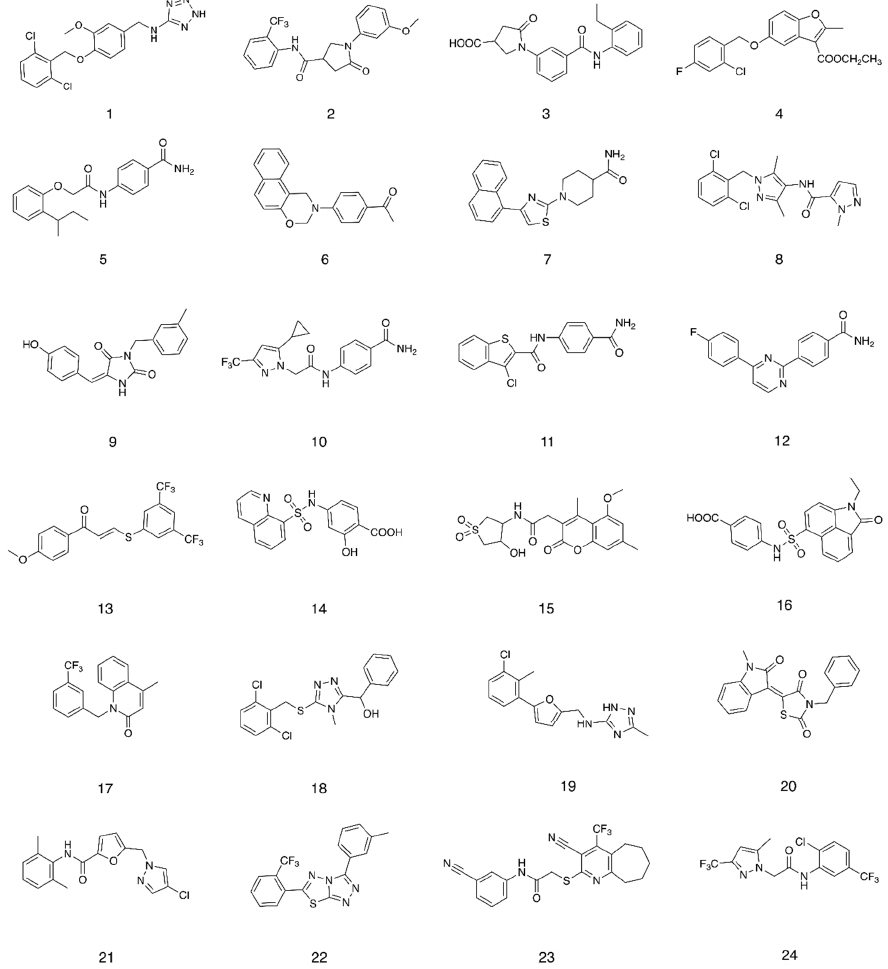
Figure 3. Compounds selected after the structure-based virtual screening and purchased from SPECS.